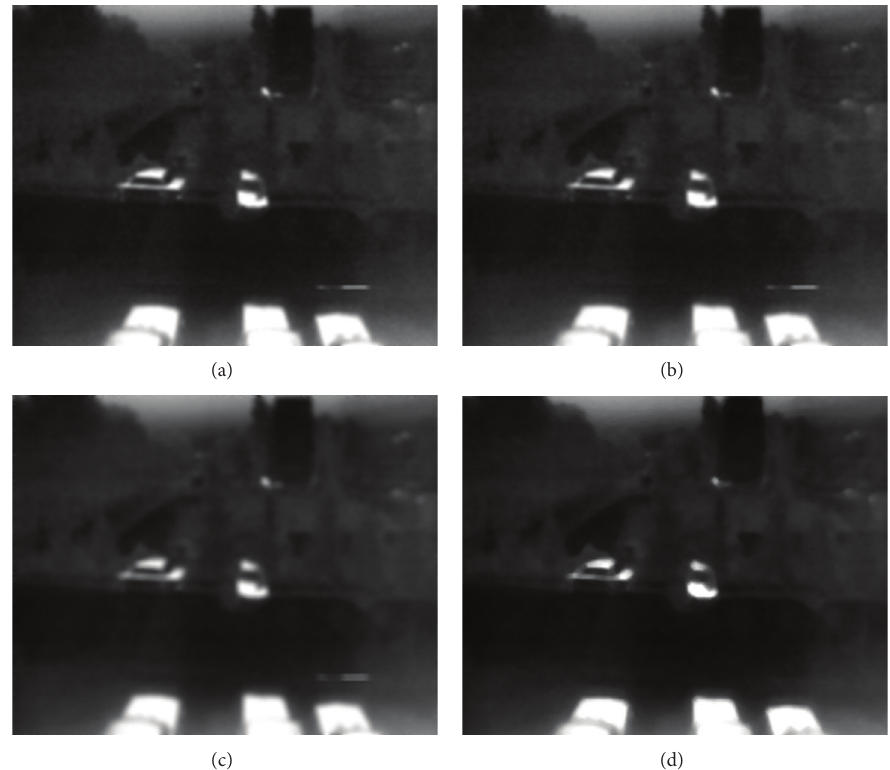
Figure 9: (a) Denoised KUT26 WSS (3 × 3 averaging filter), (b) denoised KUT26 WSS (3 × 3 averaging filter), (c) denoised KUT26 WSS (5 × 5 averaging filter), (d) and denoised KUT26 WSS (5 × 5 median